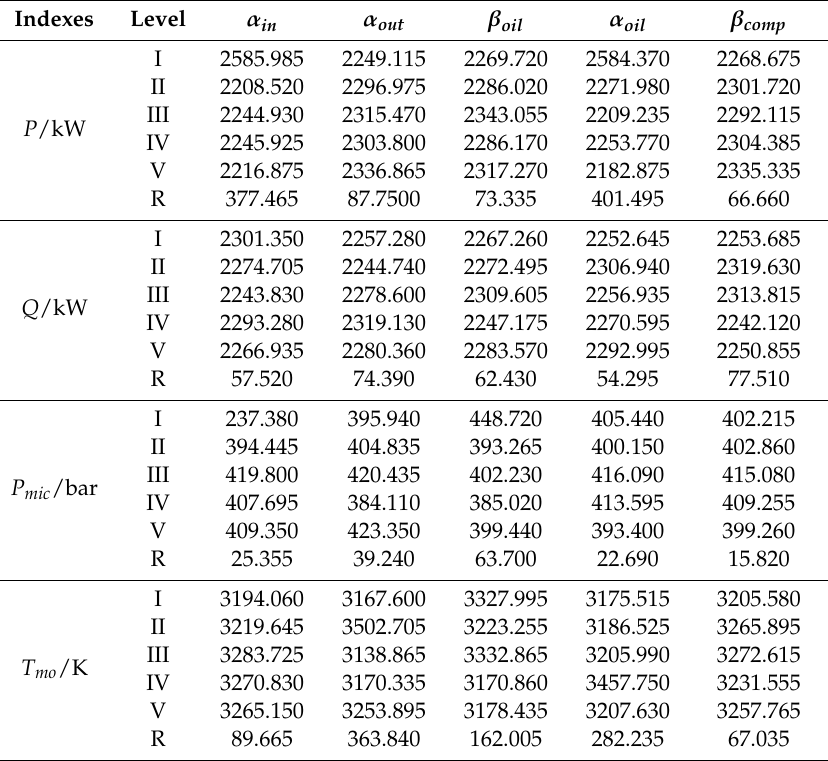
Table 6. Statistical analysis of calculation results.